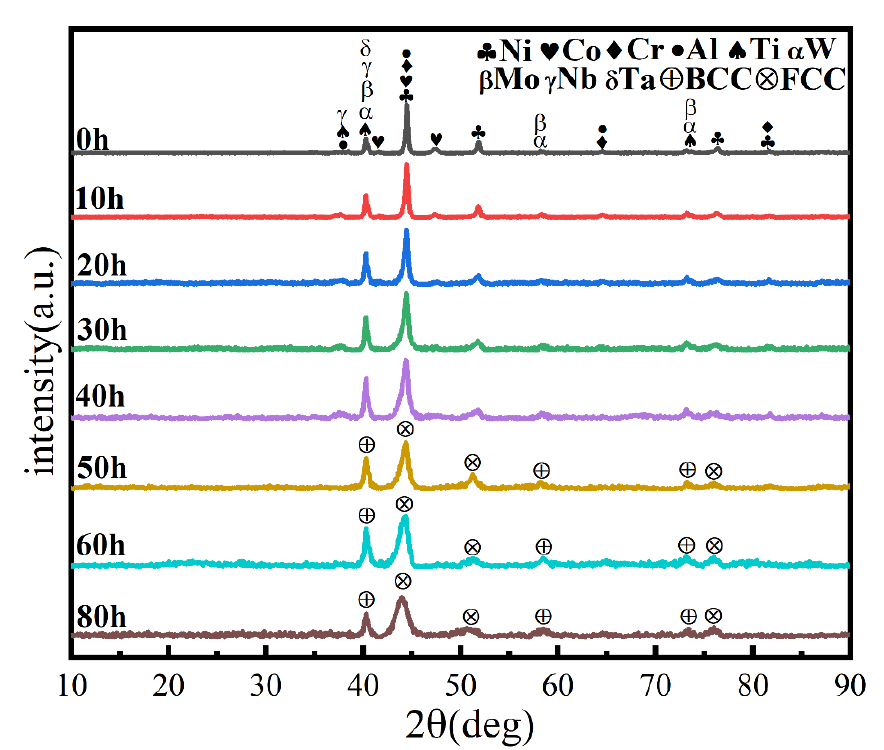
Figure 2. XRD patterns of powders at different milling times with a milling speed of 300 r min −1 and ethanol PCA.